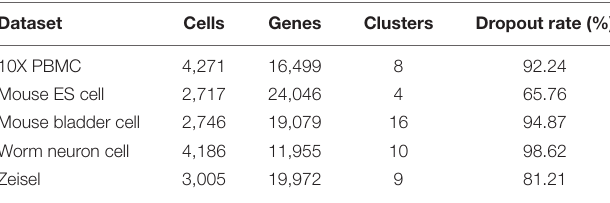
TABLE 1 | Basic information about five real single-cell RNA sequencing (scRNA-seq) datasets. Dataset